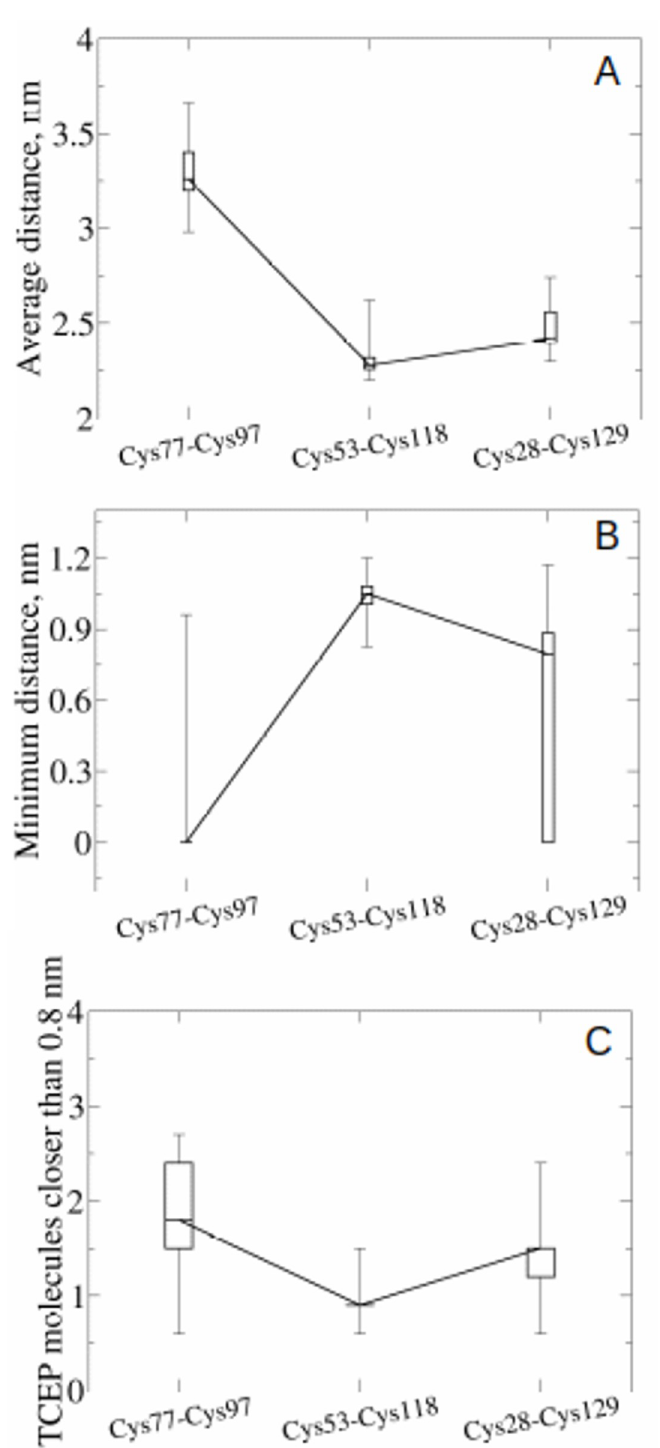
Fig 3. Selecting proximity criteria from parallel bias metadynamics. Boxplots showing (A) the average distance, (B) the minimum distance, or (C) the number of TCEP molecules closer than 0.8 nm to the disulfide bonds of CD44. In the boxplots, the top bar is the maximum observation, the lower bar is the minimum observation, the top of the box is the third quartile, the bottom of the box is the first quartile, while the middle bar represents the median. The medians are connected by a straight line to guide the